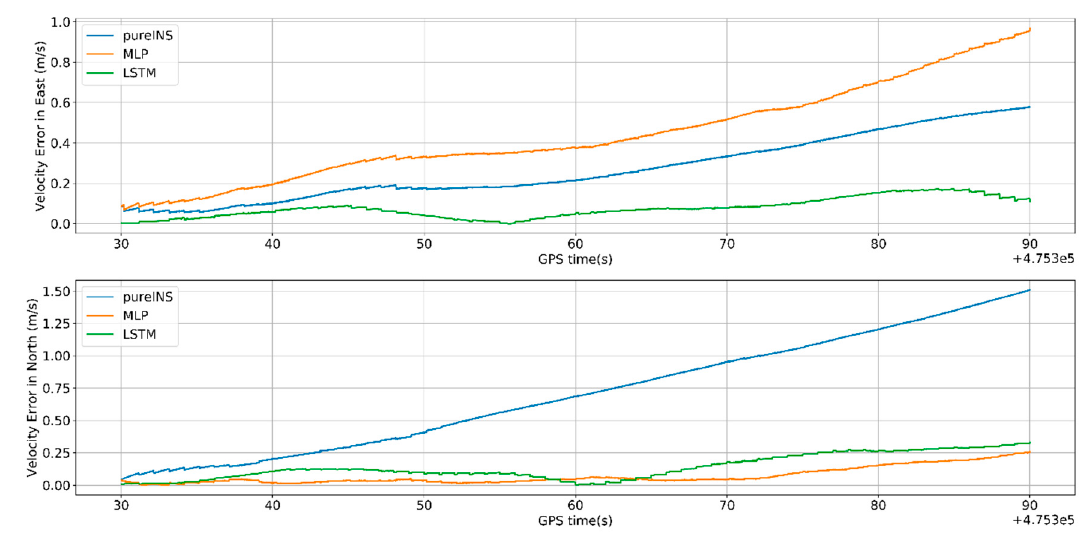
Figure 13. Velocity errors of 60 s outages with different algorithms.